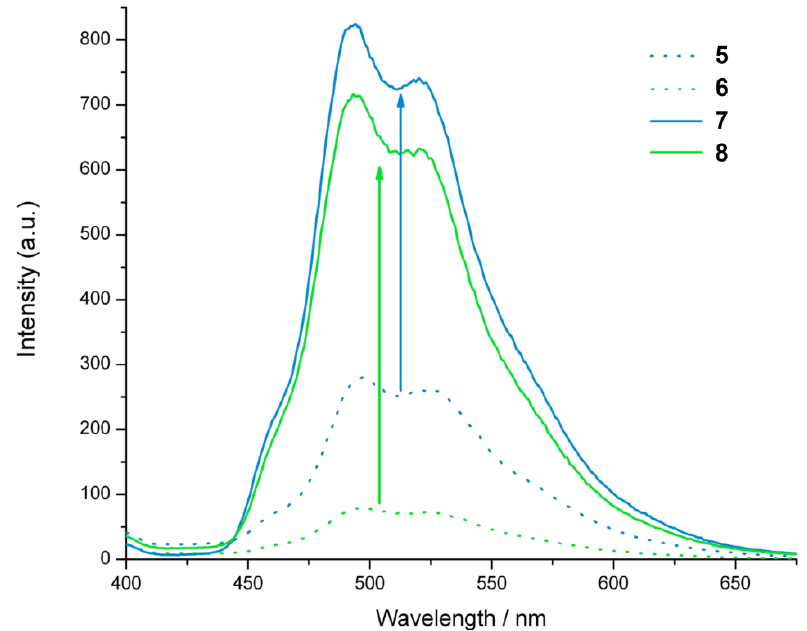
Figure 2. Room-temperature luminescence spectra of air-equilibrated iso-absorbing acetonitrile solutions of 5 – 8 . Excitation was at 350 nm. The arrows indicate the increase in emission intensity upon triazole formation.